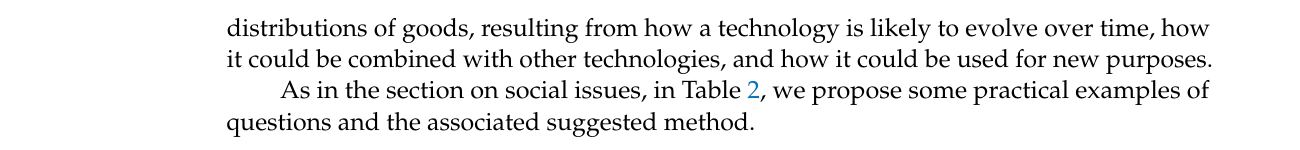
Table 2. Ethical and legal domains: practical examples of questions and suggested